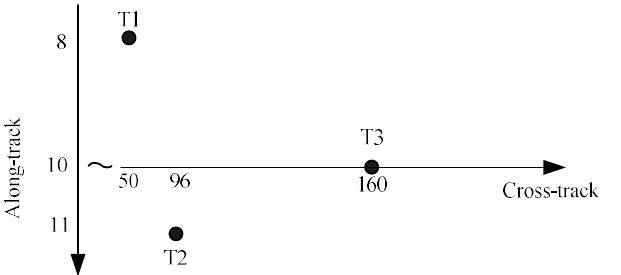
Figure 13. Distribution of simulation scene.